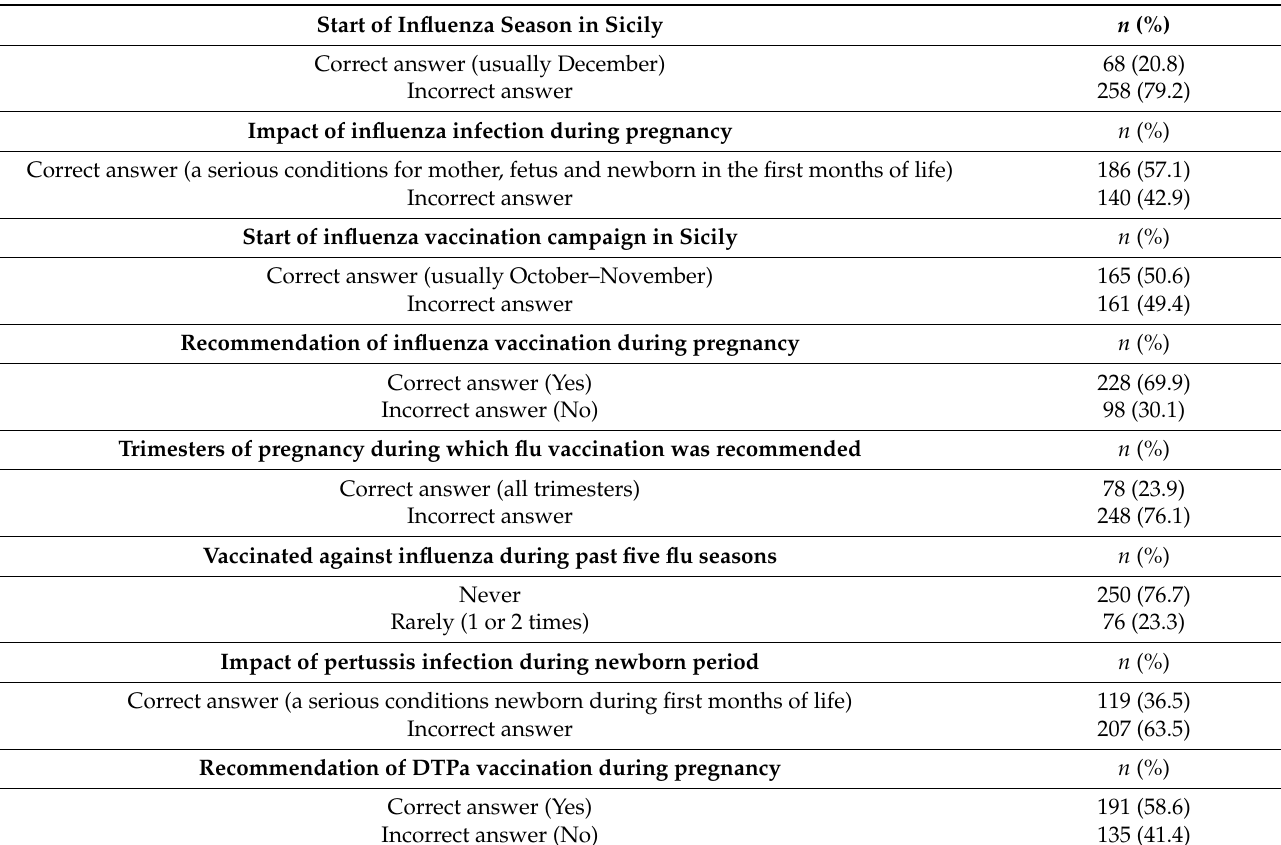
Table 3. Knowledge, attitudes, and practices about influenza and DTPa vaccinations during pregnancy of the 326 women in